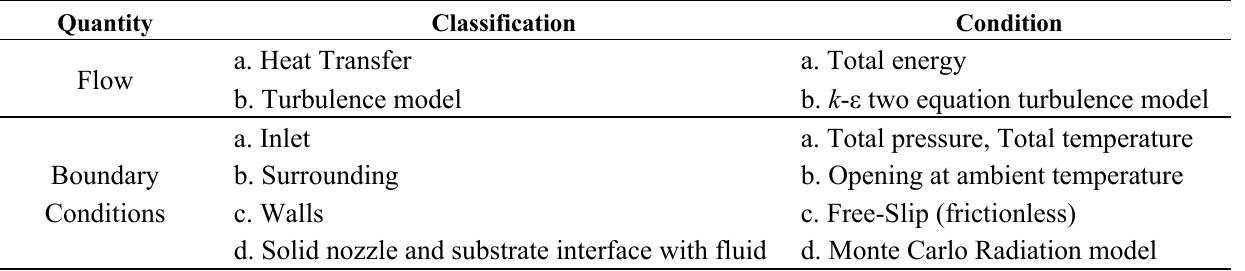
Table 1. CFD analysis flow and boundary